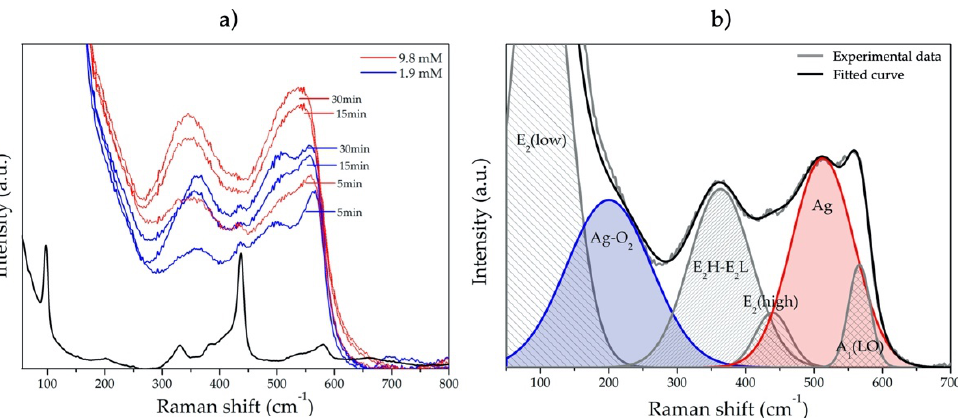
Figure 8 . ( a ) Raman spectra of the ZnO MSs (black line) and Ag/ZnO MSs obtained at 1.9 (blue lines) and 9.8 mM of AgNO 3 (Red lines), at 5, 15, and 30 min of photodeposition. ( b ) Gaussian fit of Raman spectrum of Ag/ZnO MSs obtained at 1.9 mM during 30 min.